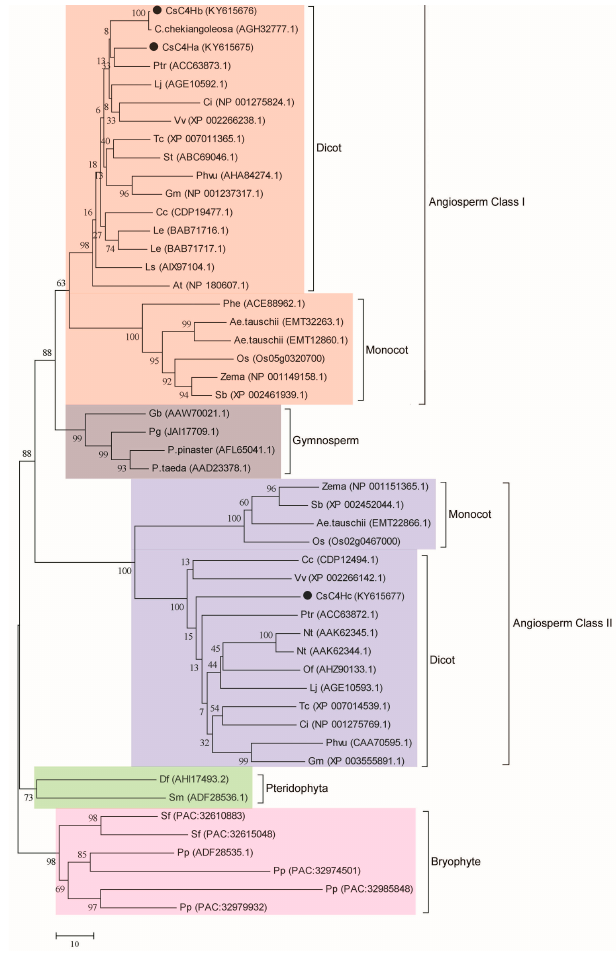
Figure 2. Phylogenetic tree of Cs C4Hs and C4Hs from other plants. The bars represent the evolutionary distance. Cs C4Hs are indicated by a circle ( ● ). The following sequences were analyzed: